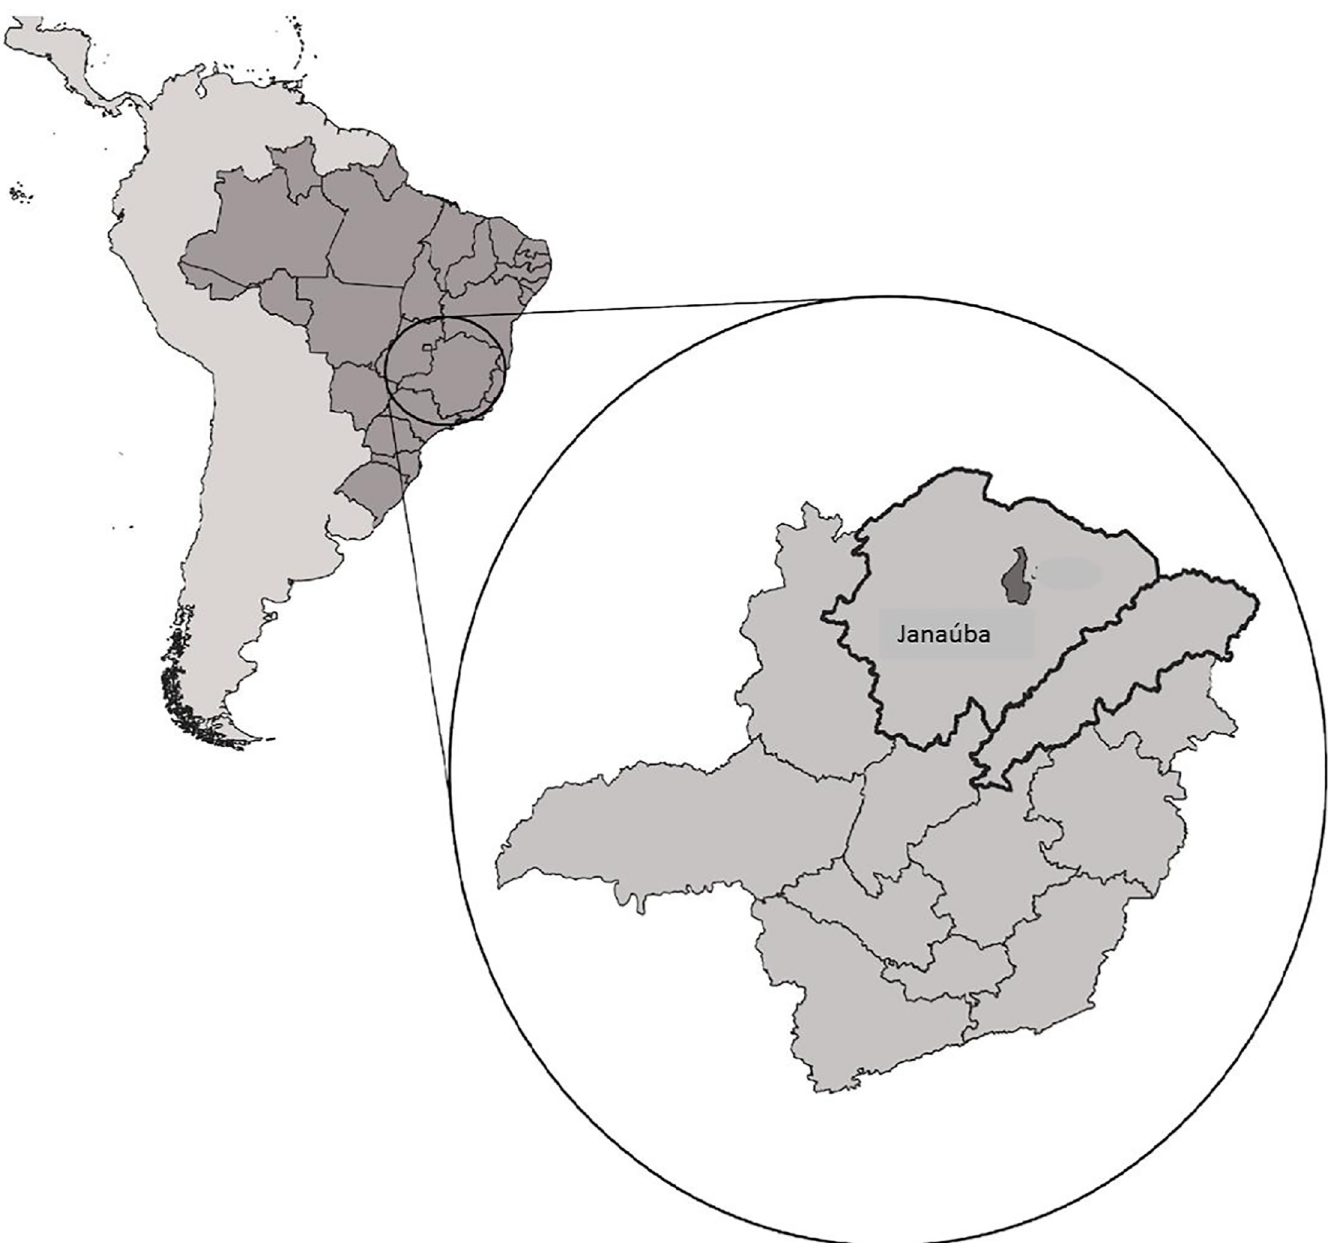
Fig 1. Location of the two regions of the state of Minas Gerais, Brazil, where the municipalities selected by the SaMiTrop cohort are